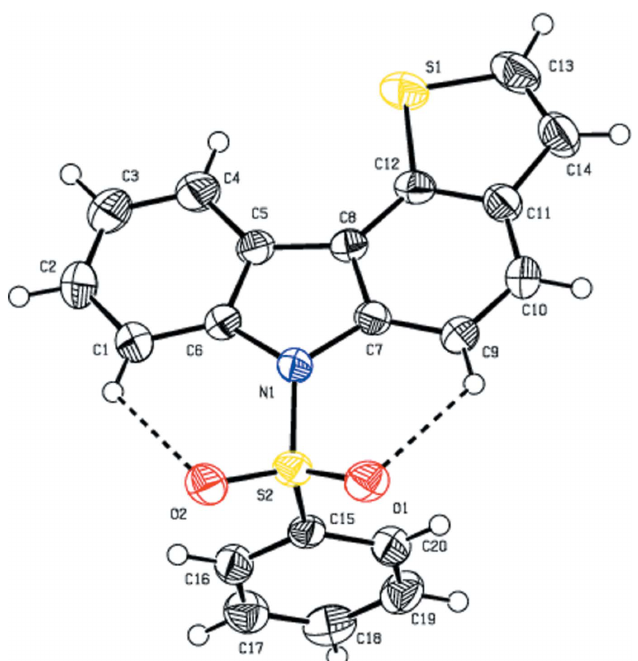
Figure 1 The molecular structure of the title compound with the atom labelling. Displacement ellipsoids are drawn at the 50% probability level. Dashed lines indicate the intramolecular C—H (cid:3)(cid:3)(cid:3) O hydrogen bonds, which generate S (6) ring motifs.